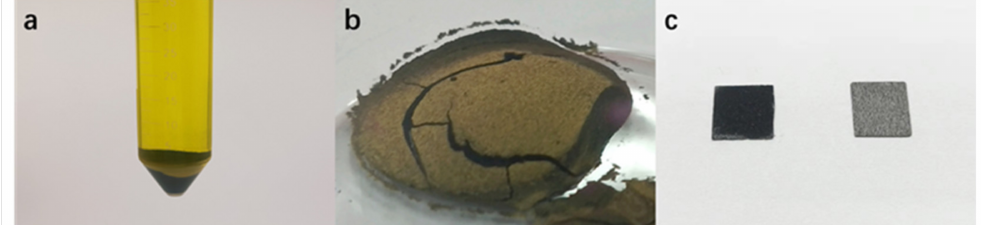
Figure 2. ( a ) The solvent and precipitation after centrifugal separation; ( b ) PAQ/MWCNTs compos- ites; ( c ) PAQ/MWCNTs modified electrode ( left ) and carbon cloth electrode ( right ). This figure was created by the